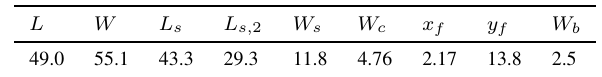
TABLE 4. Design parameters for a CP Half E-shaped patch design (units in mm) [21]